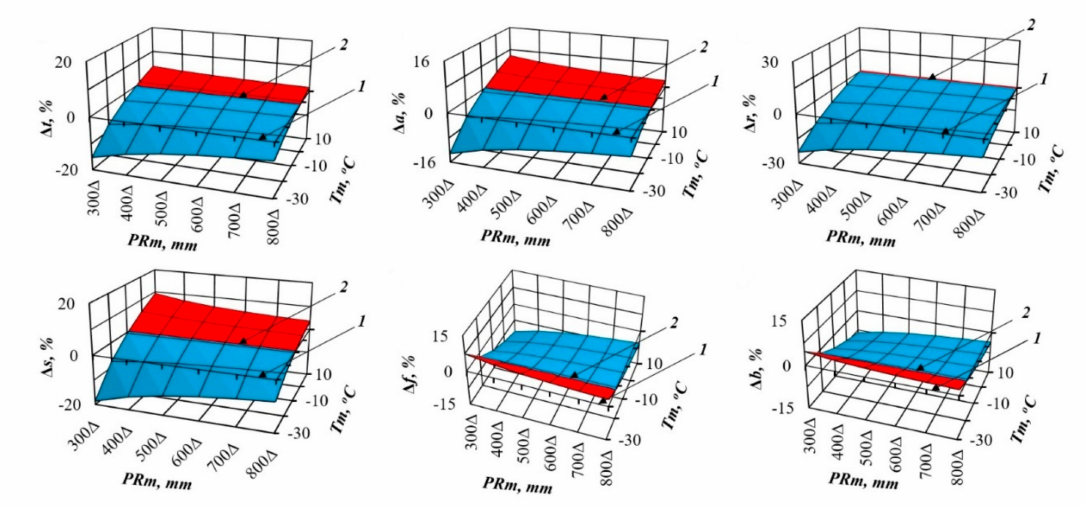
Figure 7. The theoretical changes in spruce biomass in relation to the assumed rainfall of 100 mm based on the model (1) for the stands aged 100 years. Designations: ∆ t , ∆ a , ∆ r , ∆ s , ∆ f and ∆ b are percentages of the biomass of total (above- and underground) wood storey, aboveground storey, underground storey (roots), stems (wood and bark), foliage and branches correspondingly, with a rainfall of 100